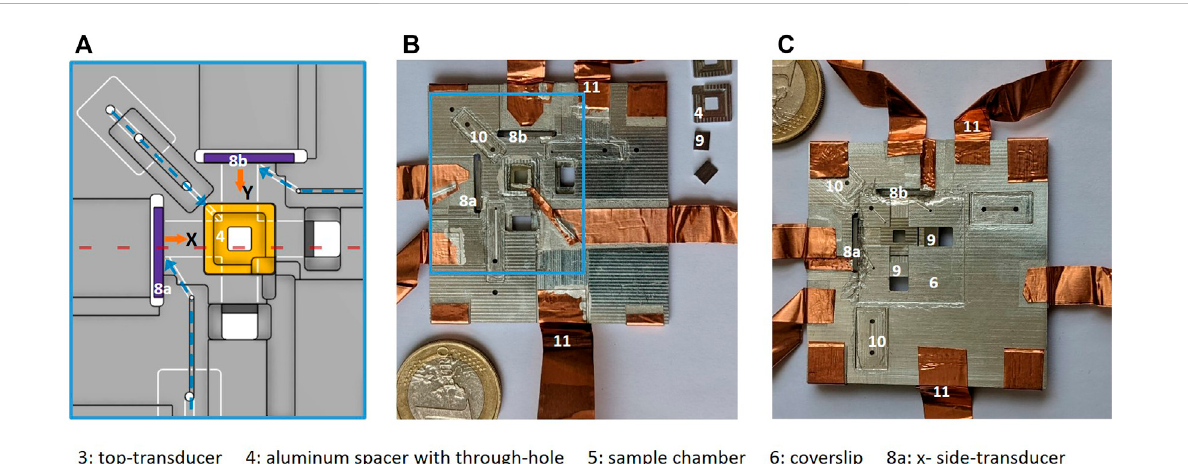
FIGURE 2 Chipassembly: (A) showsatechnicaldrawingofthemiddleareaofthechipmarkedinbluerectanglein (B) ,withaluminiumspacerinsetfortop- transducer (4, yellow), side-transducers (8a, 8b, purple) and bottom channels visible (white). The three micro fl uidic channels for fi lling the chip are marked with dashed blue arrows and each channel end up at each of the three transducers. Images of the assembled CNC-machined chip is shown with (B) top view and (C) (mirrored) bottom view, where the crossed fl uid channels from the side-transducers are visible. The micro fl uidic channels aresealedwithcover glass(10).Electrical connectiontothetransducersisachievedwithsilverpaintandcopperfoil(11).Thenumbersrefer to the components listed at the bottom of the fi